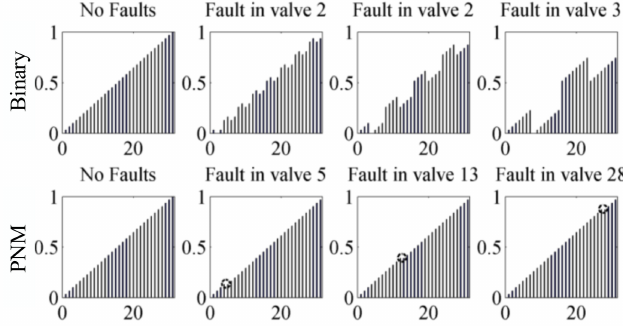
Figure 19. Fault freedom of DFCUs with di ff erent encoding modes.